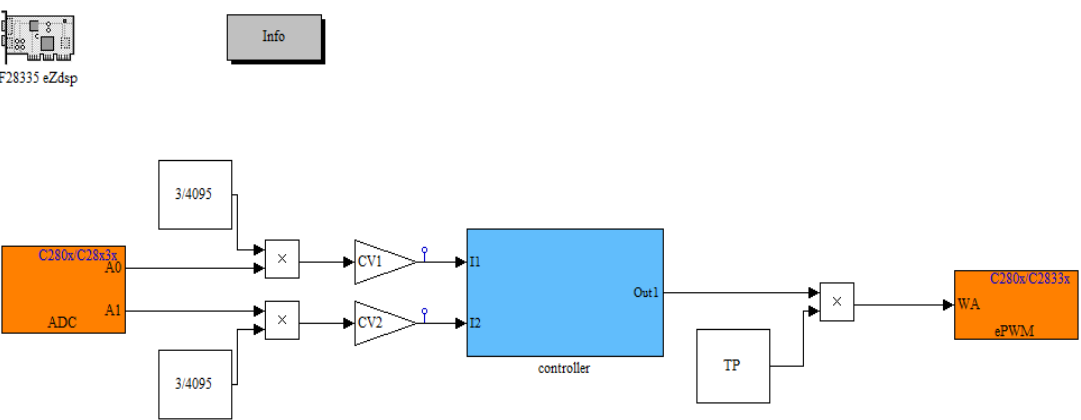
Figure 8. The general blocks in MATLAB/Simulink for programming the DSP.